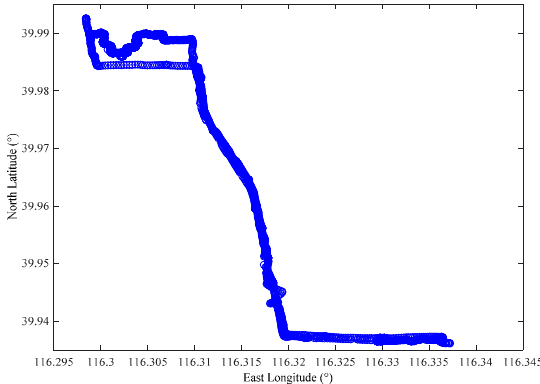
Figure 4. The schematic diagram of vehicle user trajectory.